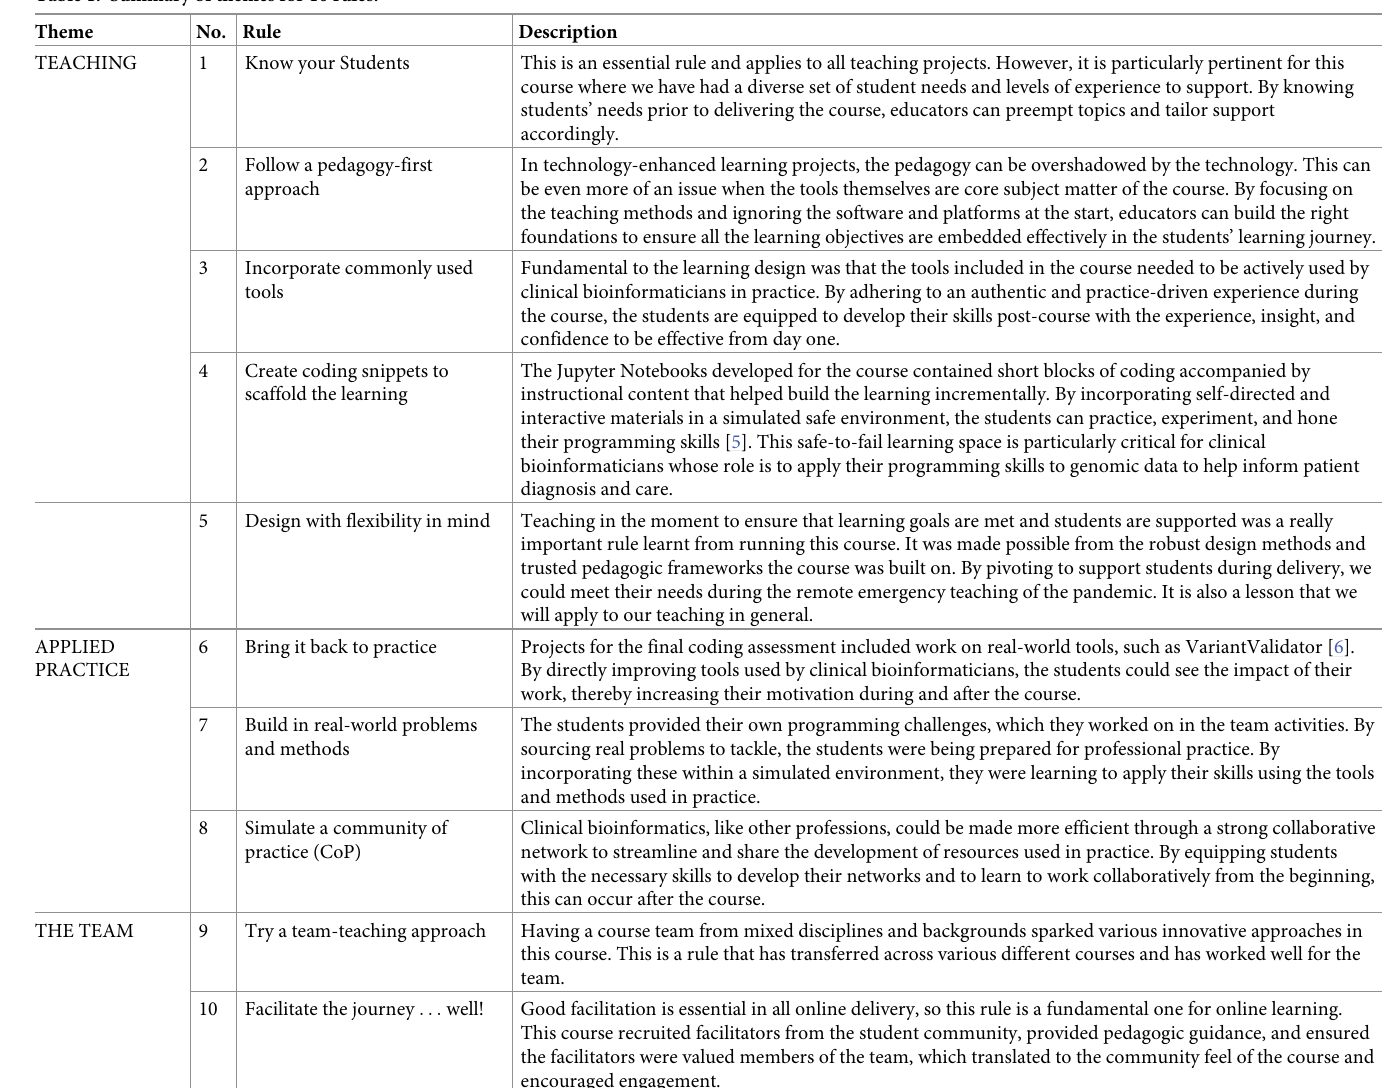
Table 1. Summary of themes for 10